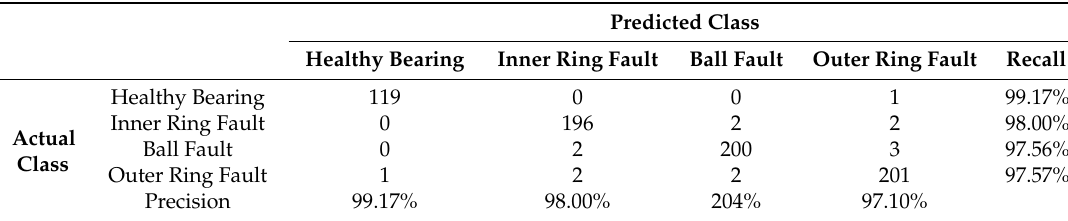
Table 1. Classification rate of LDA model (Training data).